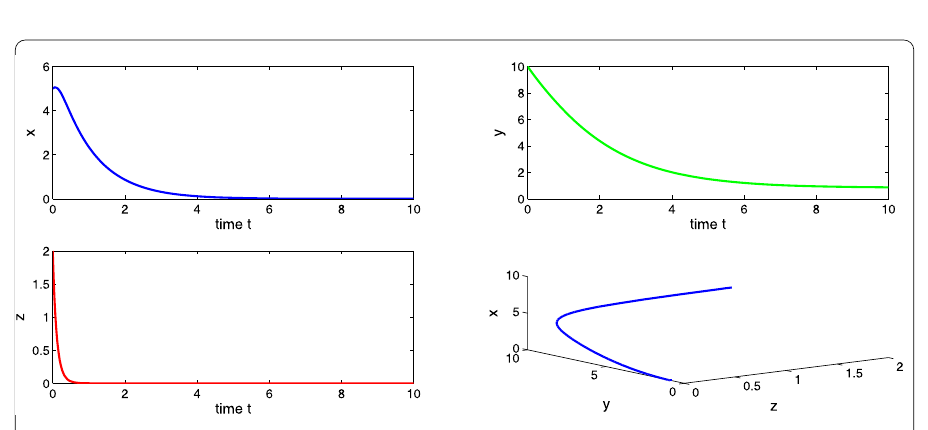
Figure 15 Time evaluation curve and three-dimensional phase portrait of the system for the parameter values a